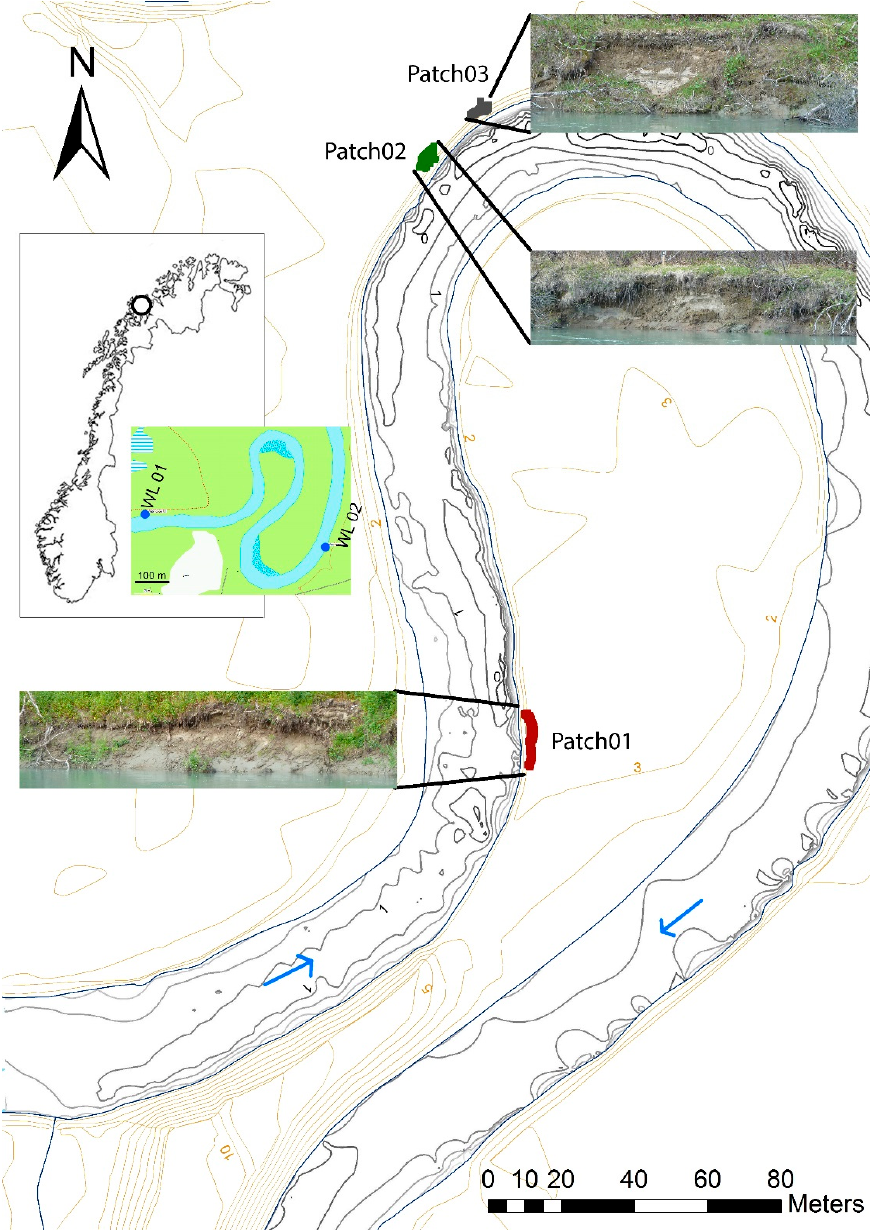
Figure 1. The investigated lowland river bend is located in the northern part of Norway. The flow is indicated by blue arrows. Investigated patches are shown at their locations. The locations of water level loggers are shown as WL01 upstream and WL02 downstream.